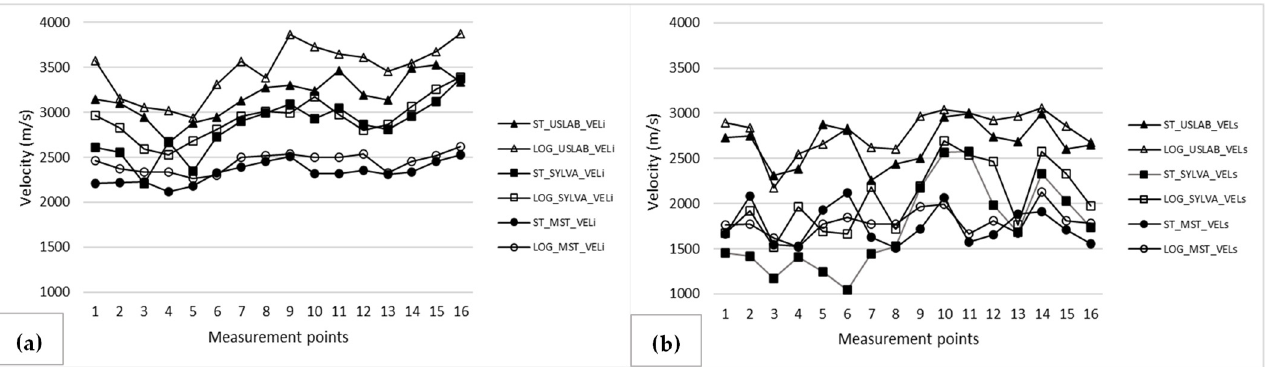
Figure 6. ( a ) Indirect velocities and ( b ) Semidirect velocities, determined on standing tree and logs in Platanus x hybrida Brot.